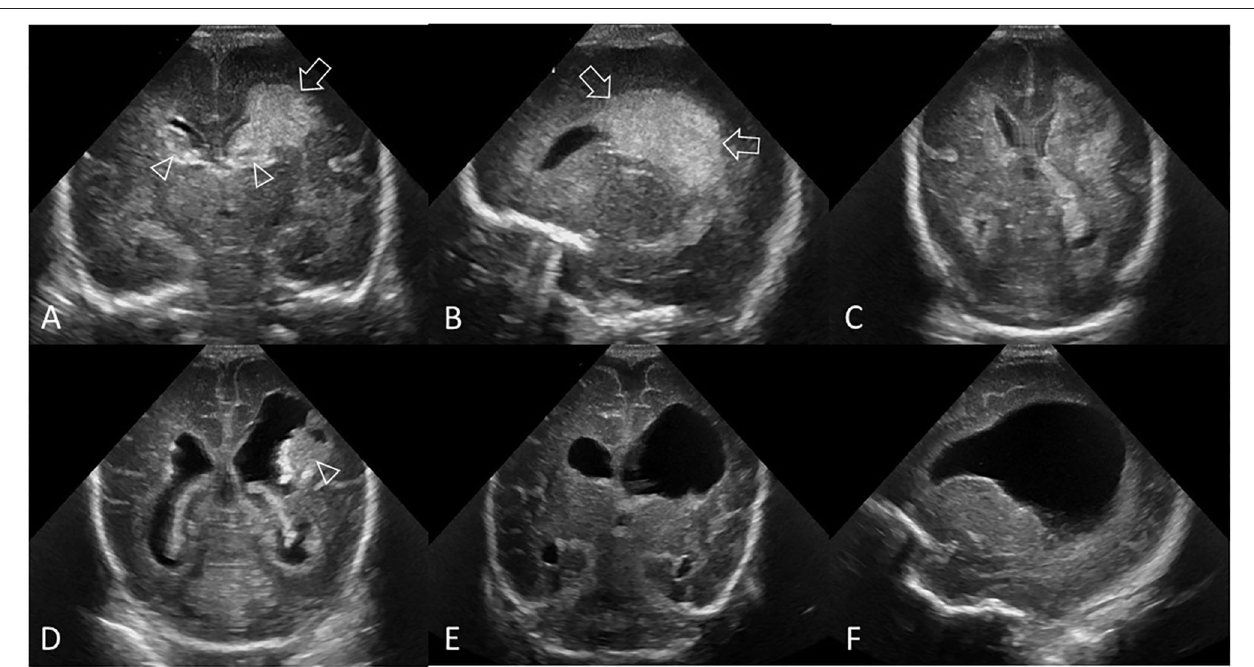
FIGURE 5 | Grade III GMH-IVH + PVHI. Ultrasound scan in a preterm infant (GA 24 weeks) with bilateral GMH-IVH and left-sided PVHI. (A) Coronal scan 2 days after birth showing a left-sided grade III GMH-IVH (arrowhead, AHW = 7mm, measurement not shown) and large echodensity in the left frontoparietal white matter (arrow). Smaller right-sided grade II GMH-IVH (arrowhead, AHW = 4mm, measurement not shown). (B) Left parasagittal scan showing the periventricular echodensity (arrows) extending from the posterior frontal white matter to the parietal white matter. (C) Follow-up coronal scan 2 weeks after birth shows the area of PVHI beginning to develop central echolucency, indicating early cystic degeneration. (D) Follow-up coronal scan 7 weeks after birth shows further cystic degeneration following the PVHI with echogenic clot debris, dilated lateral ventricles, and echogenic ependymal lining. (E,F) Follow-up coronal and left parasagittal scans at 12 weeks show the large porencephalic cyst communicating with the lateral ventricle. Internal clot debris has cleared and ependyma is no longer echogenic. The persisting ventriculomegaly is now partially passive (i.e., ex-vacuo) in origin. In this example, the independent recording of the bilateral GMH-IVH patterns on the baseline cUS exam is